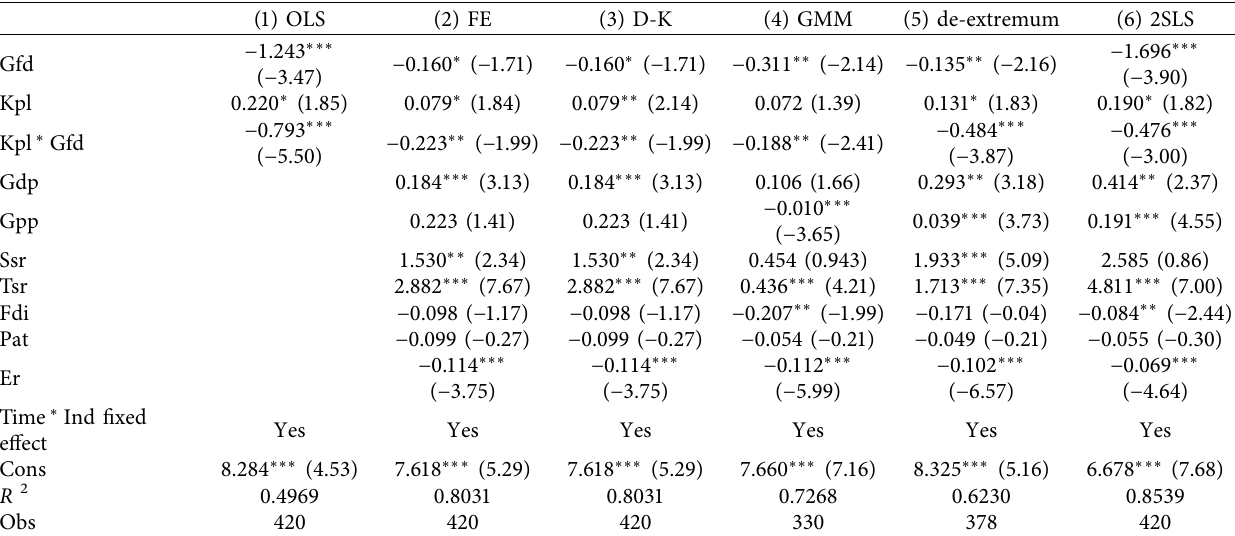
Table 5: Regression results of regulatory